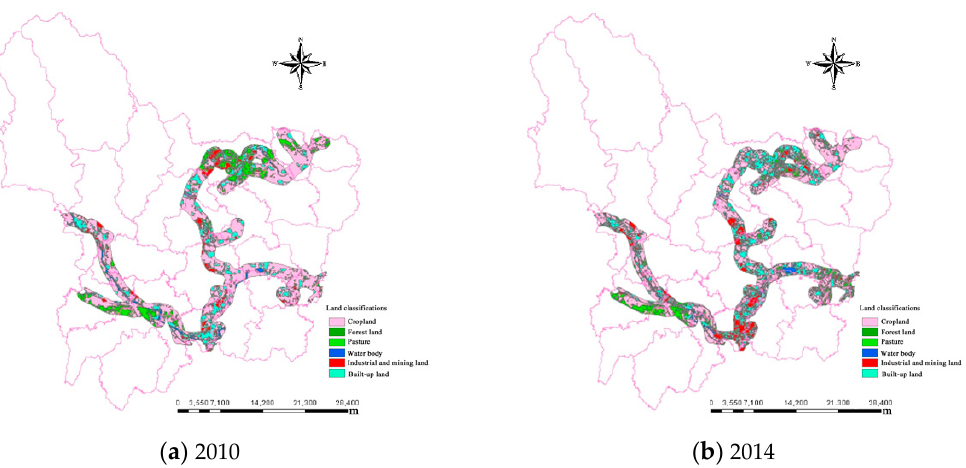
Figure 3. Land use within buffer zones along the railways of Wu’an in ( a ) 2010 and ( b ) 2014.